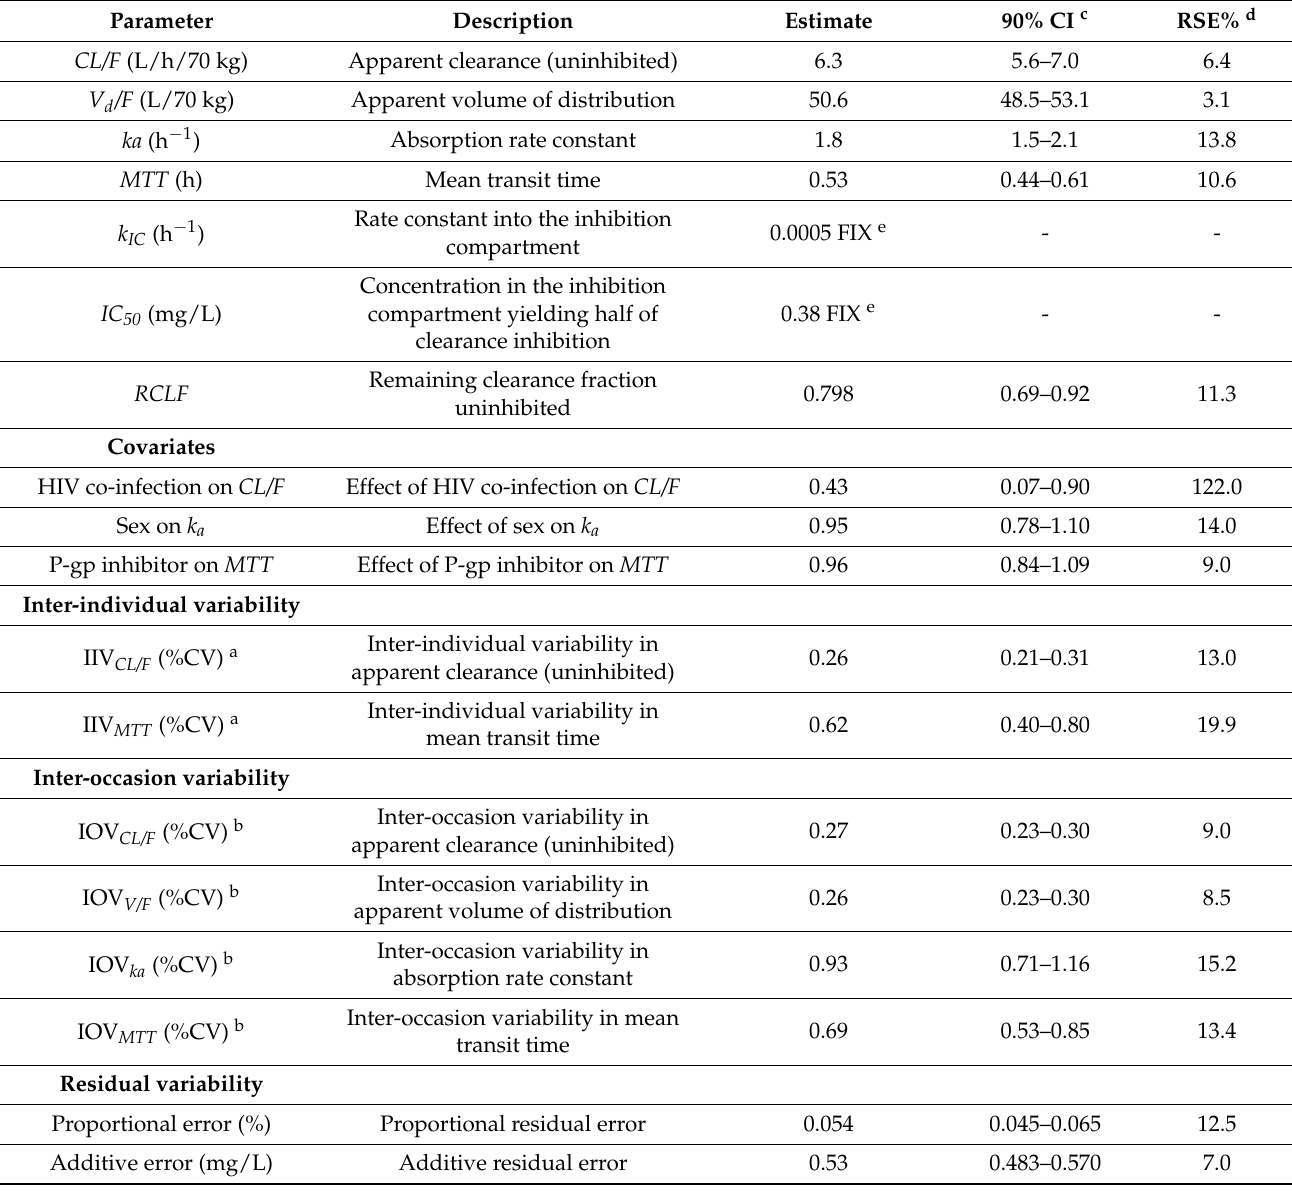
Table 2. Parameter estimates from the final linezolid population pharmacokinetic